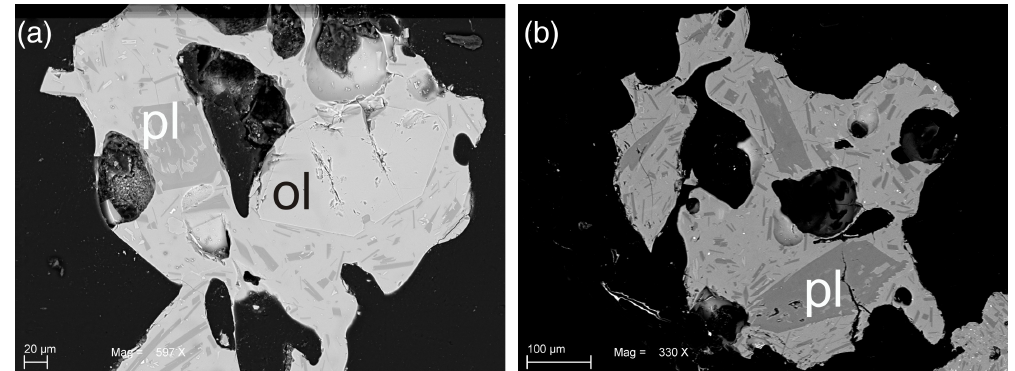
Figure 7. Scanning electron microscope secondary electrons (SEM-SE) images representative of textures identified in the 15 November 2015 ash; pl denote plagioclase; ol denotes olivine.